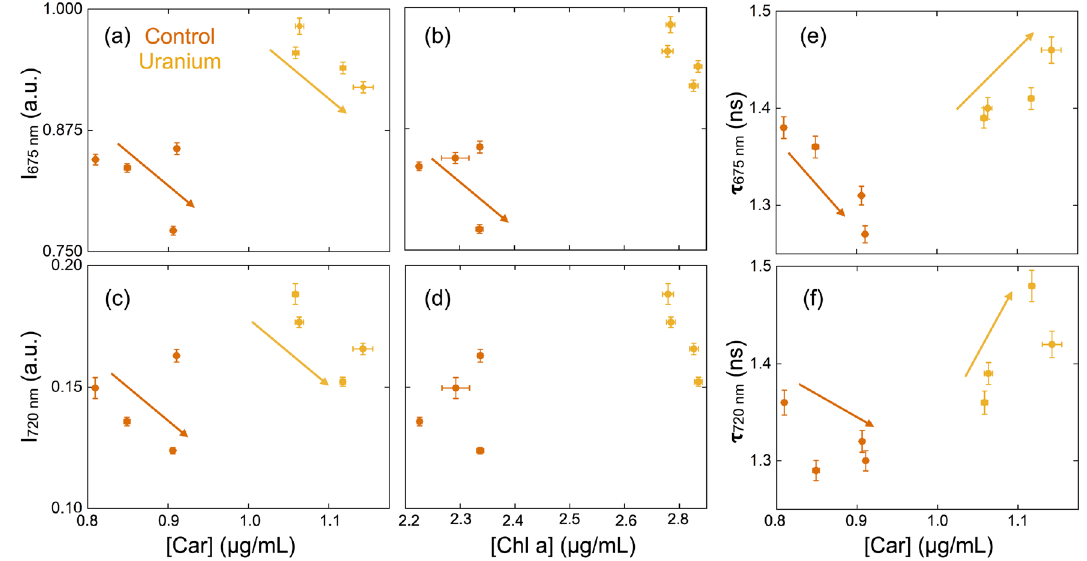
Figure 6. Time-integrated fluorescence intensity for the 675-nm peak as a function of ( a ) [Car] and ( b ) [Chl a]; similarly for the 720-nm peak in ( c , d ), respectively. The fluorescence lifetime as a function of [Car] for the ( e ) 675-nm peak and ( f ) 720-nm